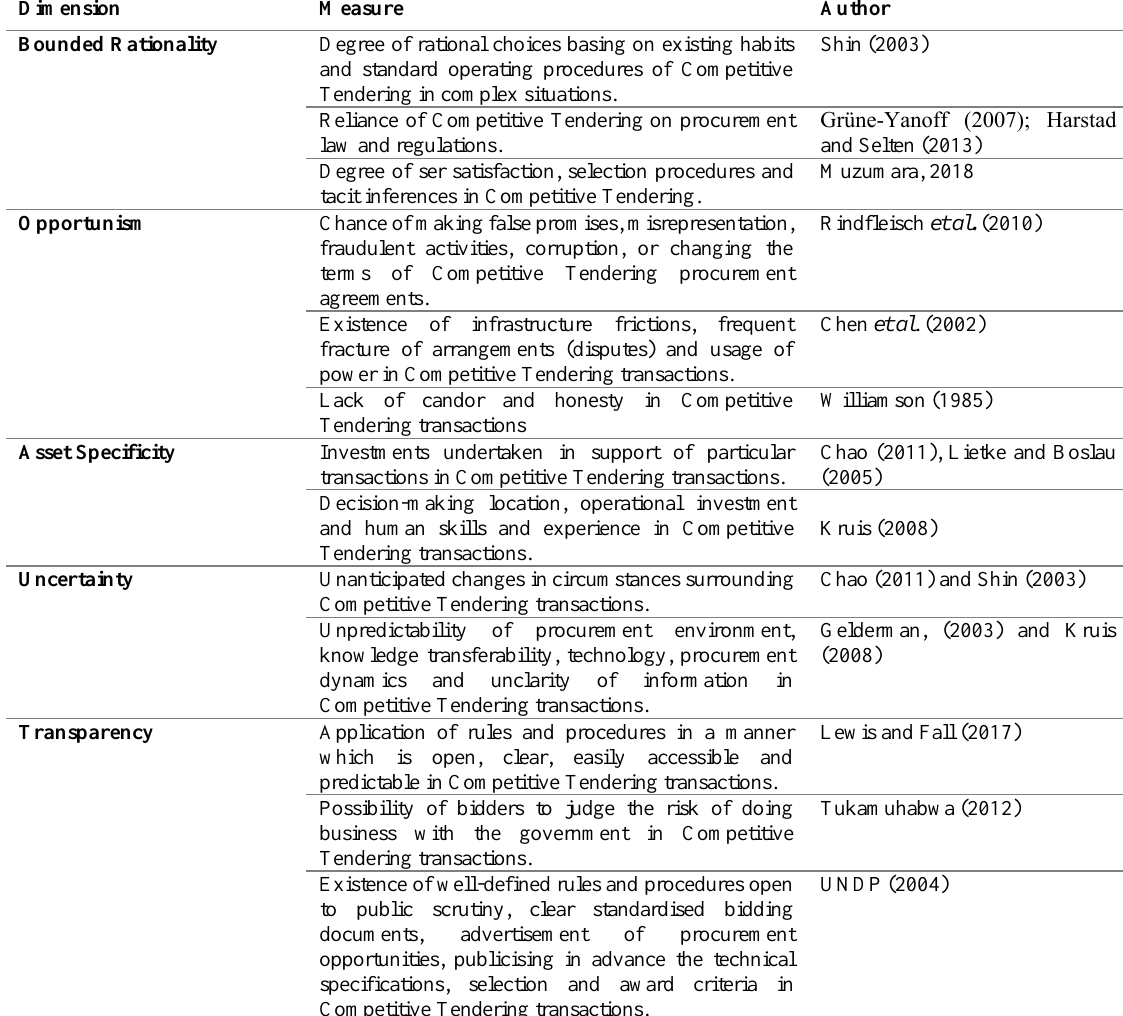
Table 1: Measurement of